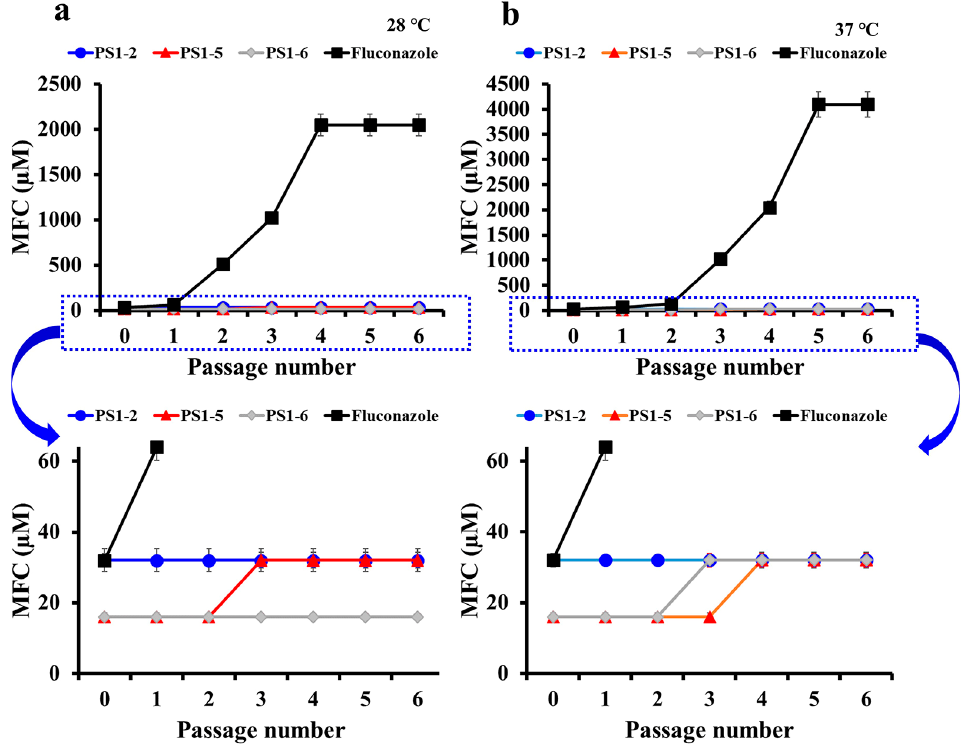
Figure 3. Induction of drug-resistance of peptides and fluconazole in C. albicans KCTC 7270 cells. Development of resistance in C. albicans cells were performed by the exposure to PS1-2, PS1-5, PS1-6, or fluconazole at 28 °C ( a ) or 37 °C ( b ) during 6 passages. The Y -axis shows the fold change of MFC from the first passage.